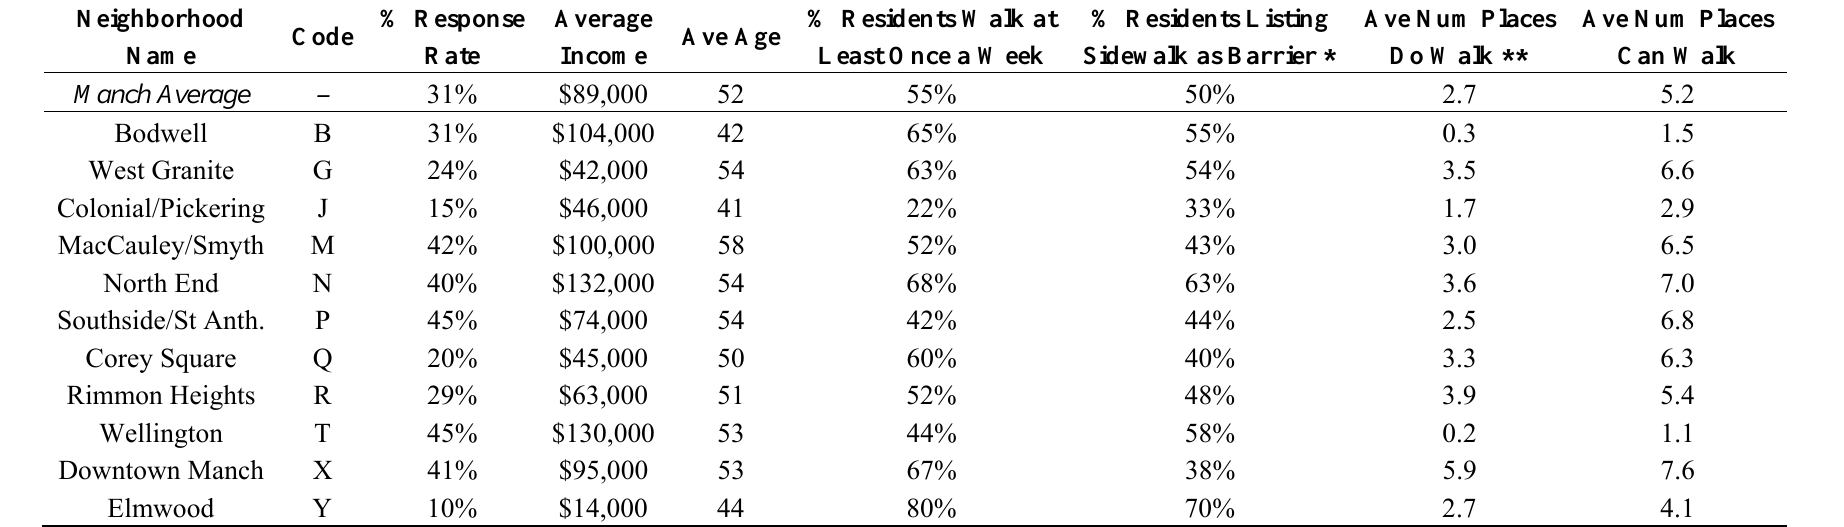
Table 2. Descriptive statistics of selected neighborhood socio-demographics and transportation